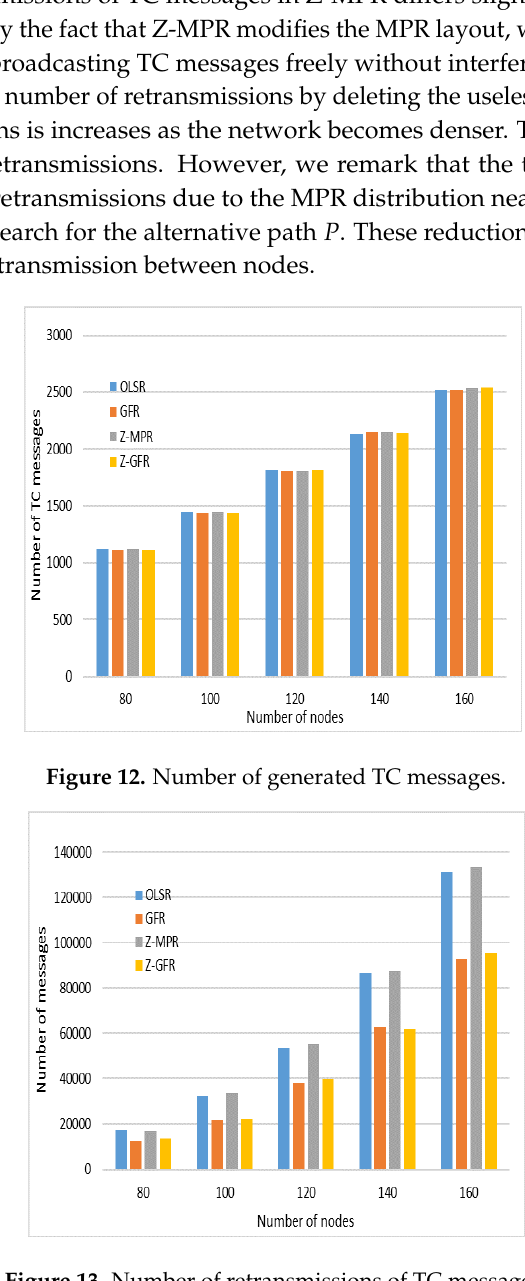
Figure 13. Number of retransmissions of TC